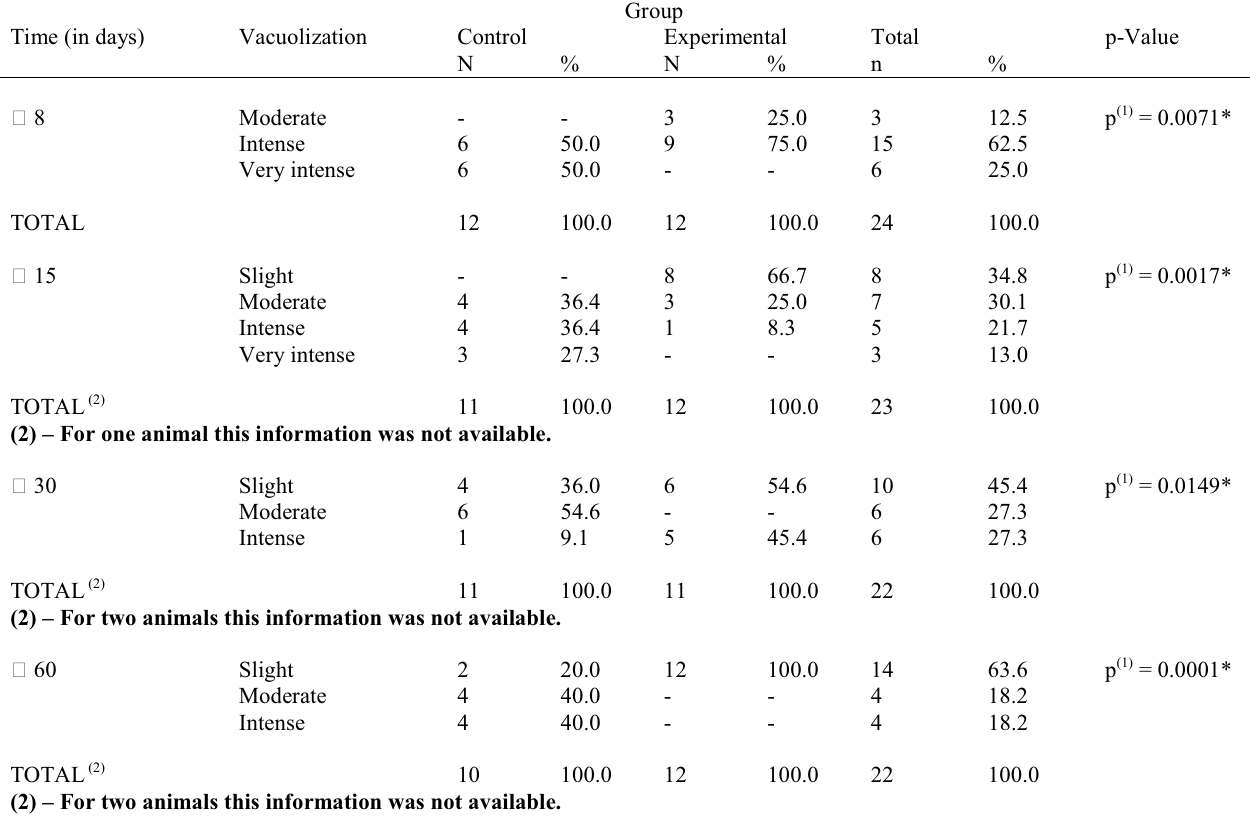
TABLE 1 – Evaluation of the vacuolization of Schwann cells and macrophages in control and experimental groups at 8, 15, 30 and 60 days